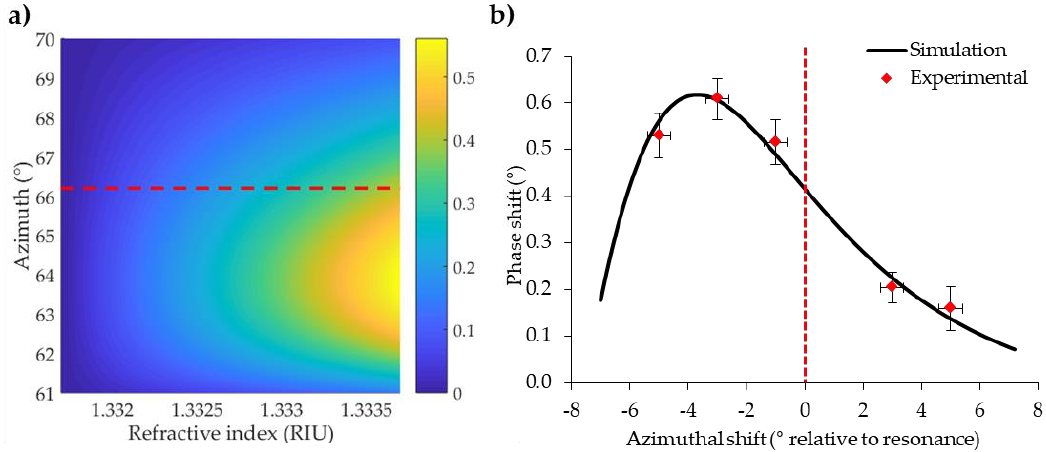
Figure 4. Numerical simulations and experimental results of azimuthal contribution to phase shift enhancement. ( a ) Simulated phase variation colour map of a grating with a period of 400 nm and 633 nm incident wavelength. The polar angle was fixed at 60 ◦ , while the azimuth was varied around resonance. The phase variation was simulated for a set of refractive indexes starting from the water. The dotted red line represents the resonant azimuth for water. ( b ) Experimental phase shift for a 200 mM NaCl solution from water (considered as reference), overlapped to the simulated longitudinal section profile from the colour map for different azimuths around resonance, at 60 ◦ polar angle. The dotted red line represents the resonant azimuth for water.